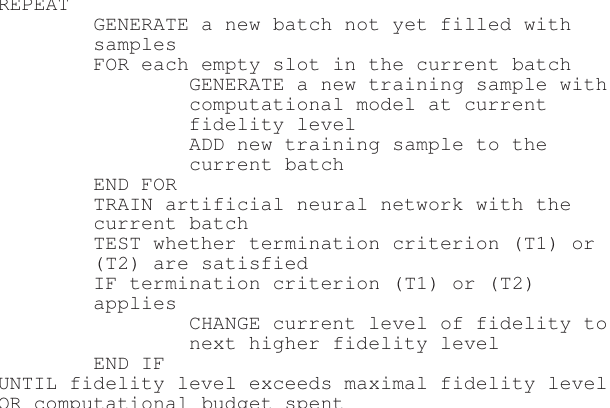
TABLE 2 | Pseudocode for unidirectional multi-fidelity training. SET current fidelity level to the lowest one REPEAT GENERATE a new batch not yet filled with samples FOR each empty slot in the current batch GENERATE a new training sample